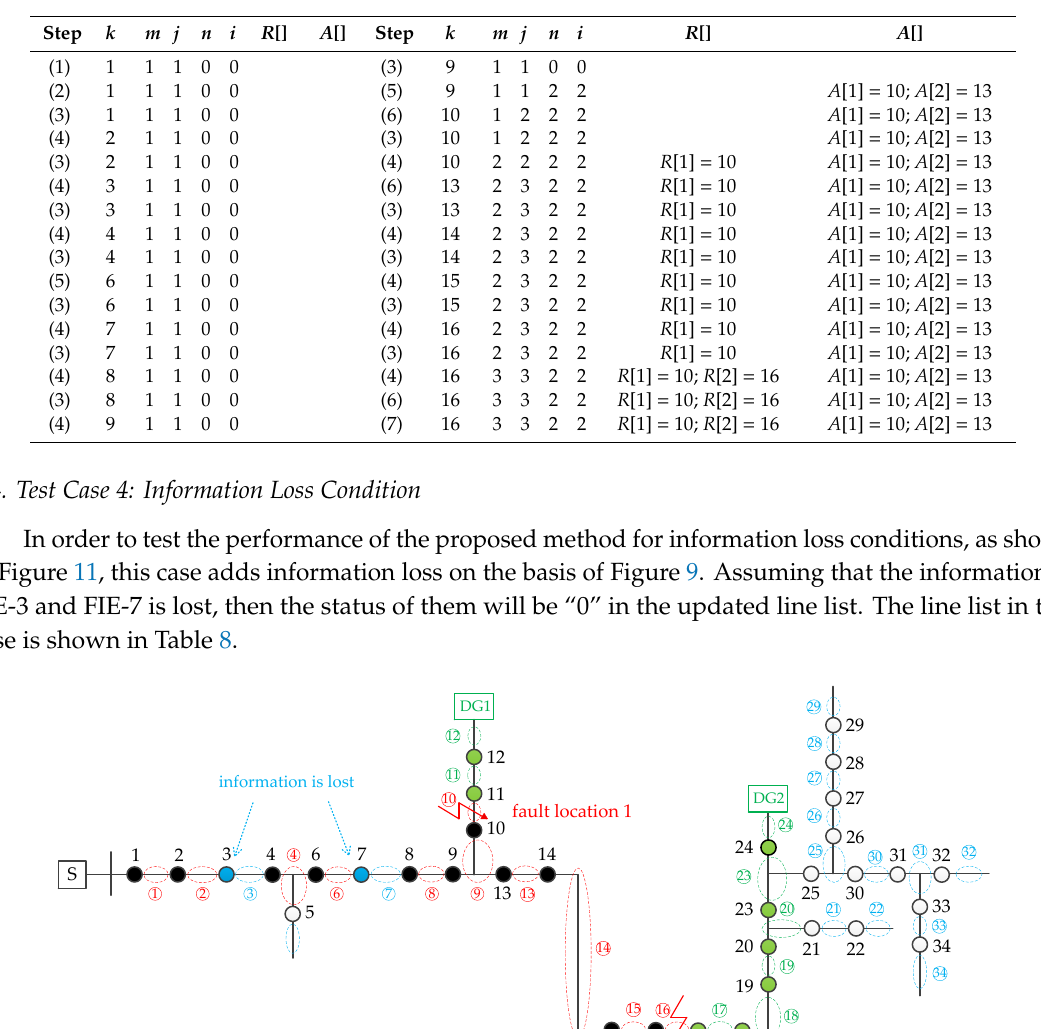
Figure 11. Information loss in the IEEE-34 node distribution network.